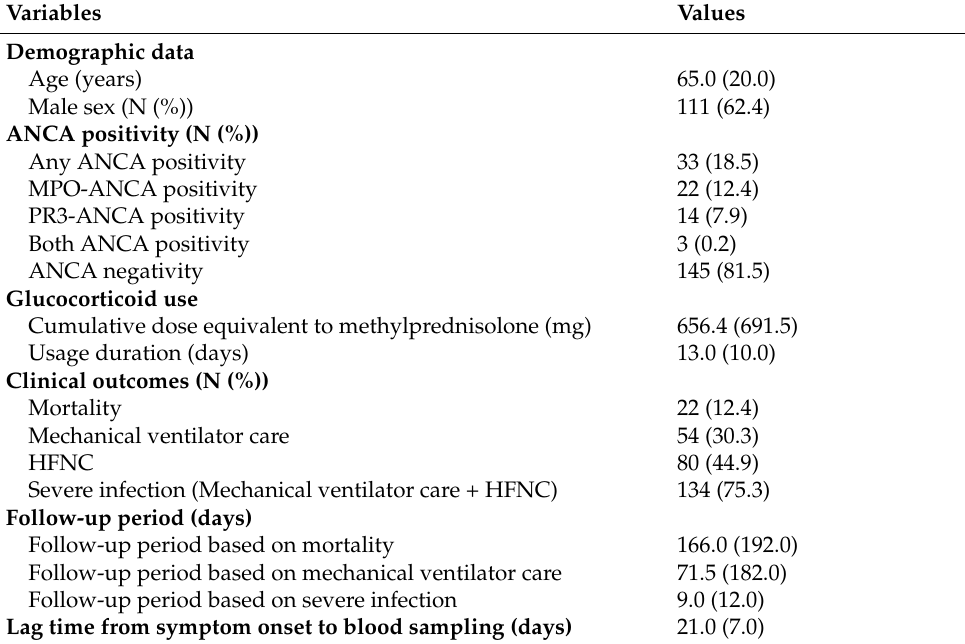
Table 1. Characteristics of patients infected with SARS-CoV-2 ( n =